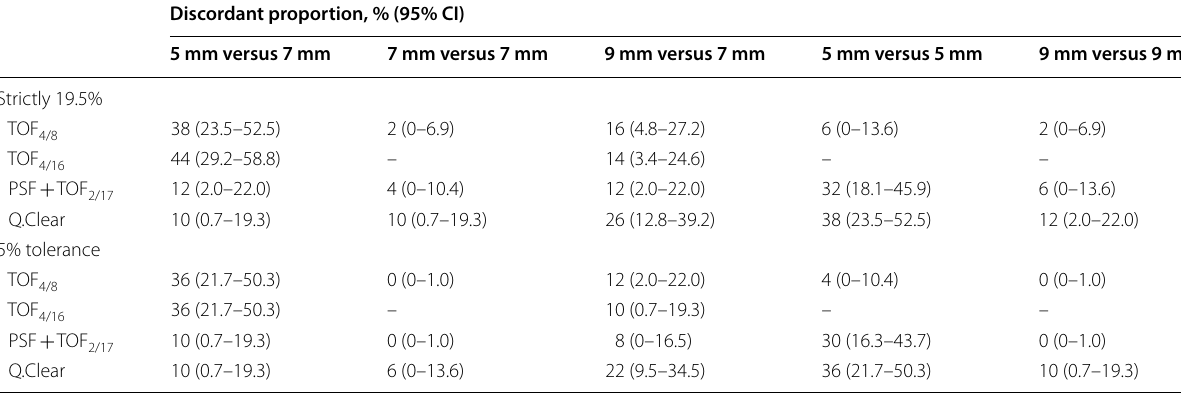
Table 3 Discordant cases relative to the reference algorithm (ASP)